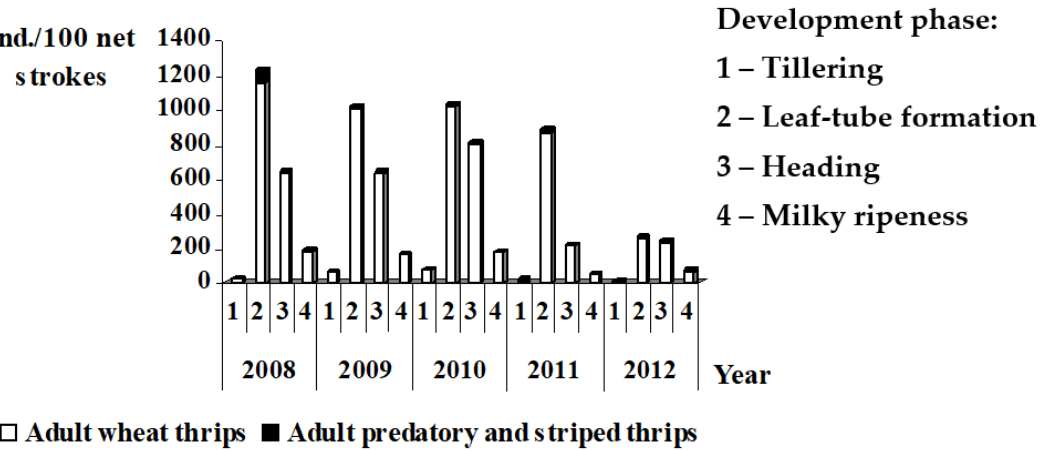
Figure 2. Abundance of adult wheat thrips and adult predatory and striped thrips in agrocenoses of spring wheat, ind./100 net strokes.